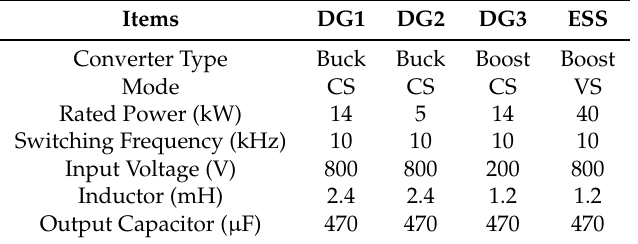
Table 1. Converter configurations. CS: current source; and VS: voltage